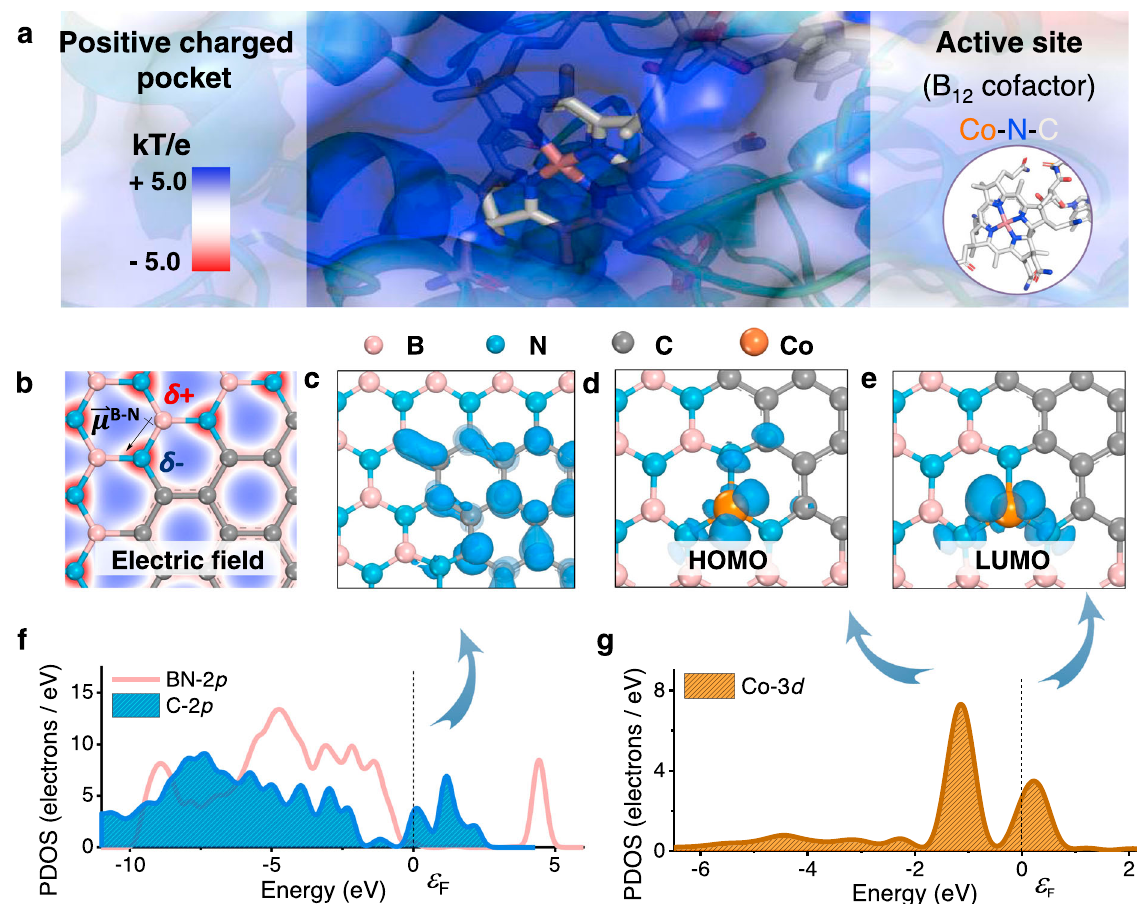
Fig. 1 DFT calculations of Co SAs/BCN. a Electrostatic surface representation of the Rdh; the potential contour was scaled to + 5.0 (blue) and − 5.0 (red) k Te − 1 (where k T is temperature, and e is the charge of an electron). b Electron density plots of BCN with the electric fi eld B B is the Boltzmann constant, around B – N bond; the isosurface contours reveal discontinuity in electron density between the N (negative charged) and B (positive charged) atoms. c Orbital density images of C atoms in BCN. d HOMO and e LUMO of isolated Co atom supported on BCN. f PDOS plot of BN-2 p and C-2 p orbitals. g PDOS plot of Co-3 d orbitals; the peaks were imaged in d , e